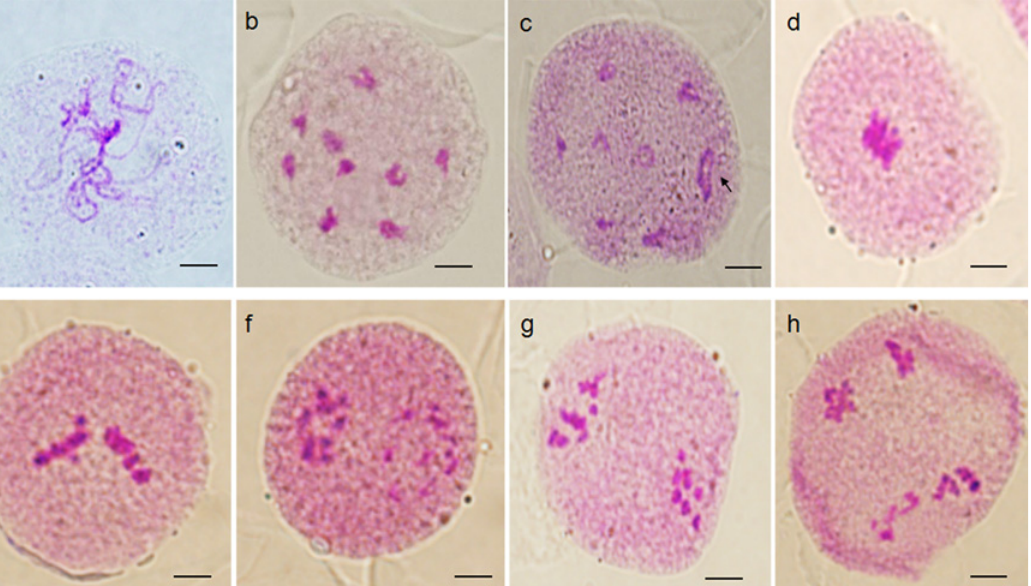
Fig 5. Meiotic analysis of ‘ Valencia ’ sweet orange. Pachytene(a), diakinesis(b and c), metaphase I (d), anaphase I (e), metaphase II (f), anaphase II (g), and telophase II(h). Chromosome pairing at diakinesis showed 9 bivalents in b, and 7 bivalents + 1 quadrivalent in c. Arrow in c indicates quadrivalent. Bar = 5 μ